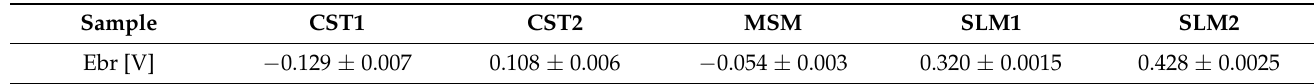
Table 6. Values of the breakdown potential calculated from the potentiodynamic curves.